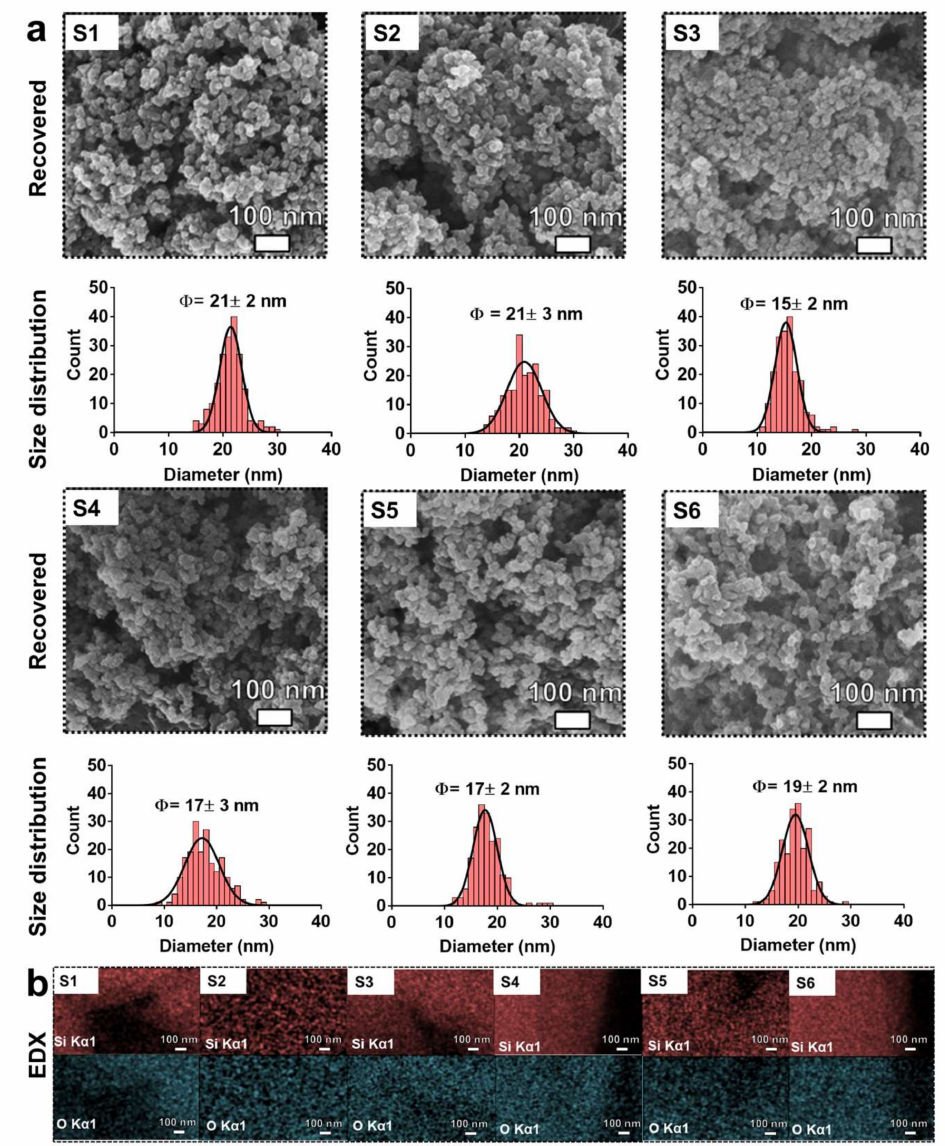
Figure 5. ( a ) SEM images and corresponding size distribution of recovered SiO 2 using SBP- MBP@SMMBs from commercial processed foods. ( b ) EDX elemental mapping of the corresponding SEM image of ( a ). Elemental silica (Si) and oxygen (O) are represented by red- and cyan-dots, respec- tively. S1, noodle soup powder; S2, chicken stock powder; S3, Coffee creamer; S4, Coffee mix; S5, Milk tea powder; S6 Potato